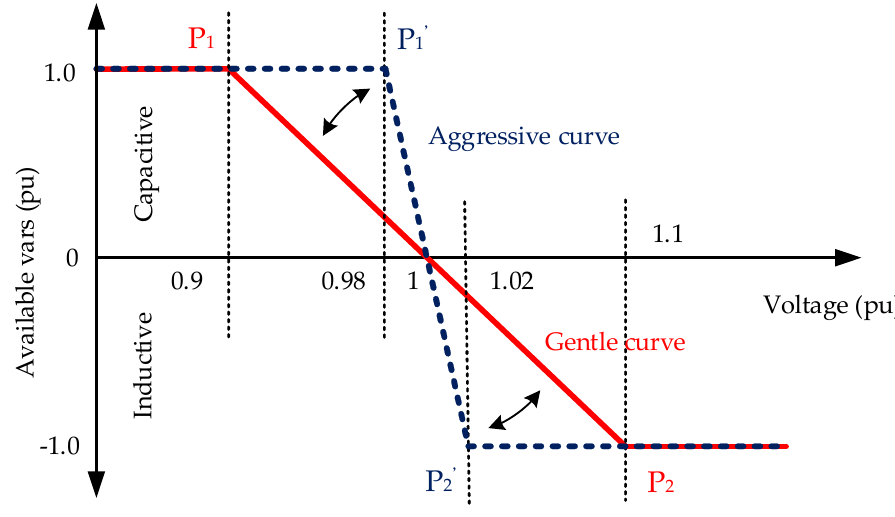
Figure 3. Volt-var control curve Figure 3. Volt - var control curve setting. Figure 3. Volt - var control curve setting.